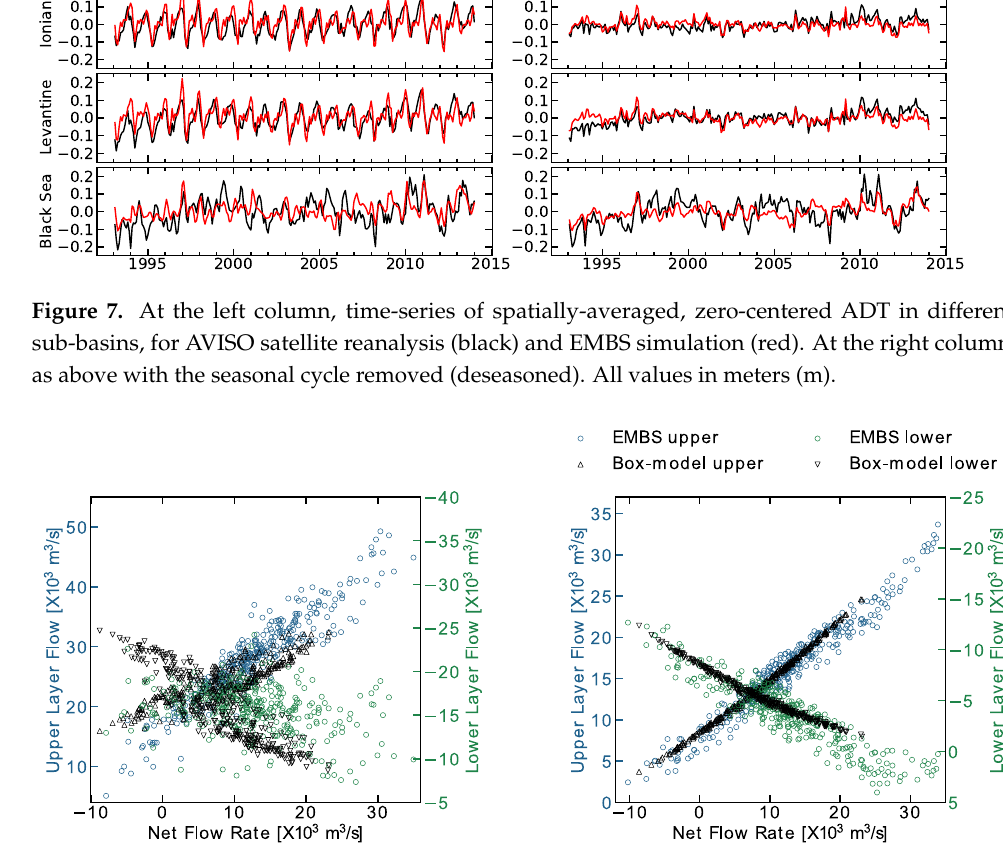
Figure 8. Volumetric water exchange at Dardanelles ( left ) and Bosphorus ( right ), for the two-layers flow. The upper and lower layer flows ( y -axes) are compared to the net exchange ( x -axes). Results of EMBS simulation are shown with circles, while results from the model of Maderich et al. described in Section 2.3, are shown with triangles, for the whole period in monthly-averaged